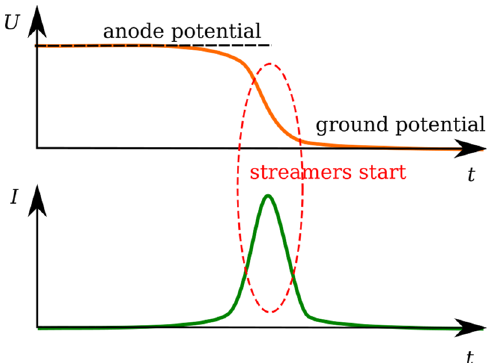
Figure 1. Experimental setup. ( a ) Block diagram of the setup. ( b ) Block diagram of the power supply of the high-voltage discharge.